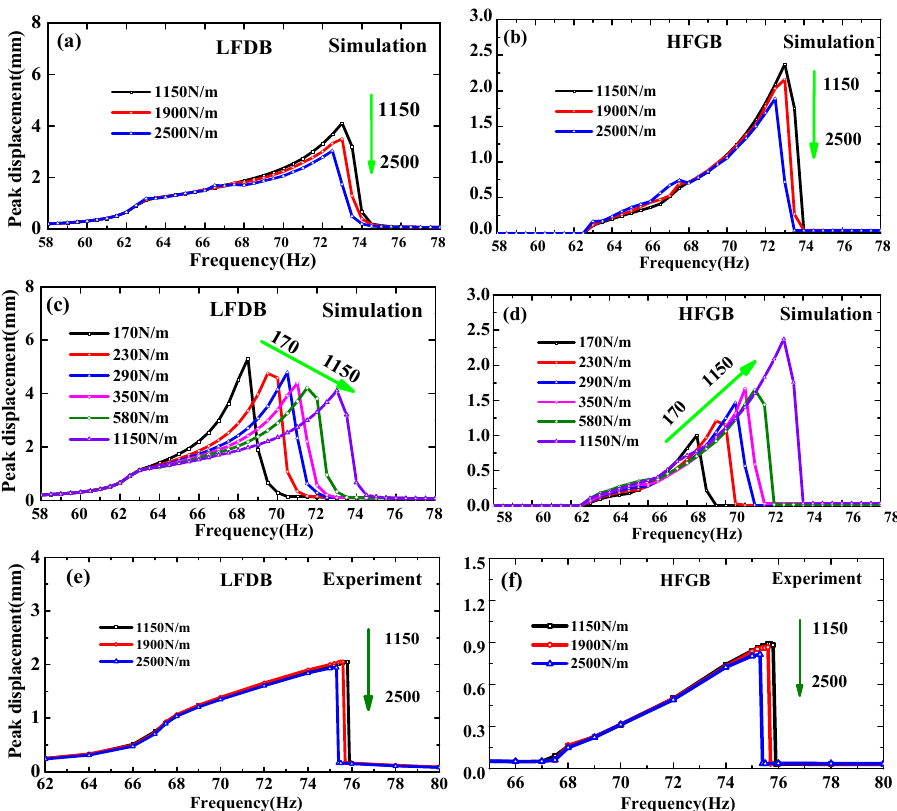
Figure 9. Frequency responses of the peak displacement of LFDB and HFGB for various rope stiffness under the condition of a = 0.6 g and Δ x = 1.0 mm: ( a ) simulation frequency responses of LFDB under k 0 = 1150–2500 N/m; ( b ) simulation frequency responses of HFGB under k 0 = 1150–2500 N/m; ( c ) simulation frequency responses of LFDB under k 0 = 170–1150 N/m; ( d ) simulation frequency responses of HFGB under k 0 = 170–1150 N/m; ( e ) experimental frequency responses of LFDB under k 0 = 1150–2500 N/m; ( f ) experimental frequency responses of HFGB under k 0 = 1150–2500 N/m.